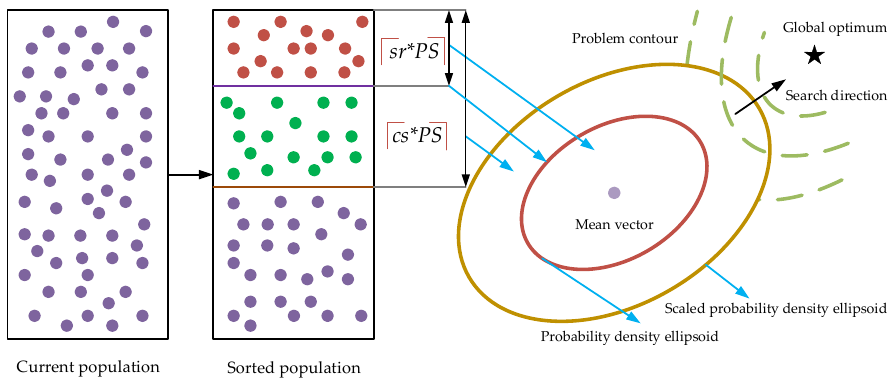
Figure 1. The visual structure of the covariance scaling strategy.